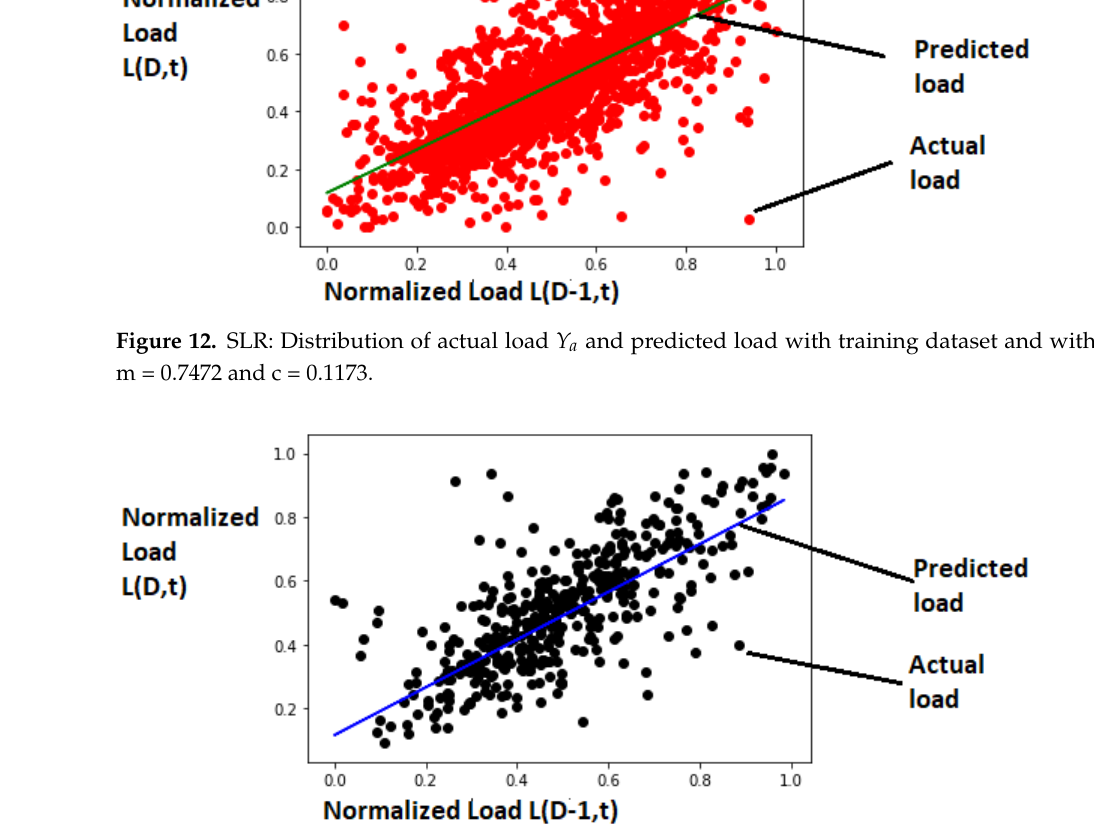
Figure 13. SLR: Distribution of actual load Y a and predicted load with testing dataset and with m = 0.7472 and c = 0.1173.